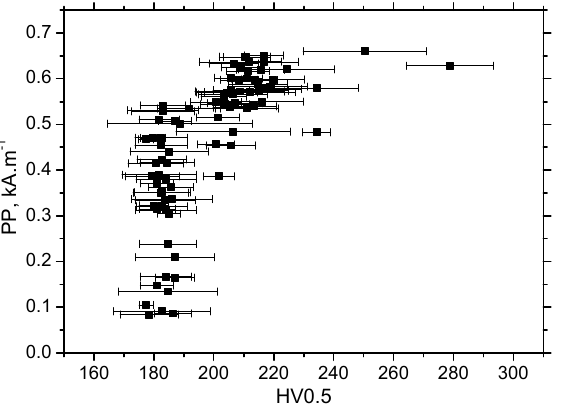
Figure 21. PP versus HV0.5, RD.